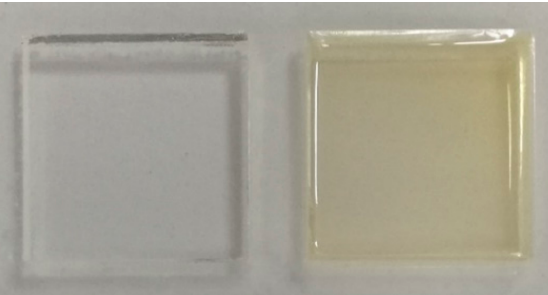
Figure 1. Scheme of the film preparation.